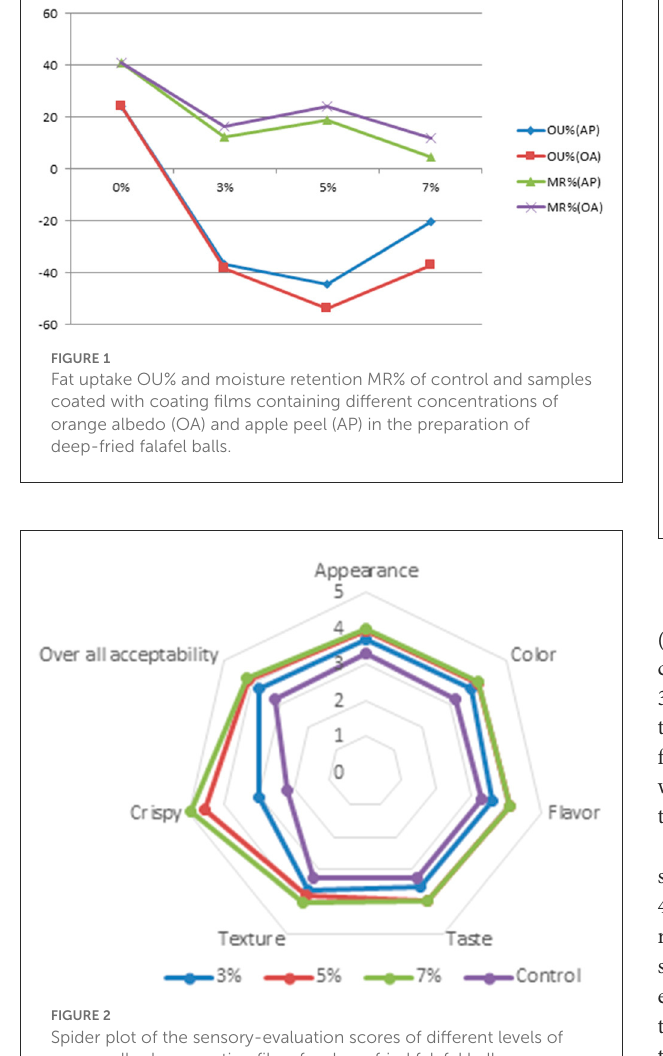
gelation led to a reduction in oil uptake and an increase in moisture retention.